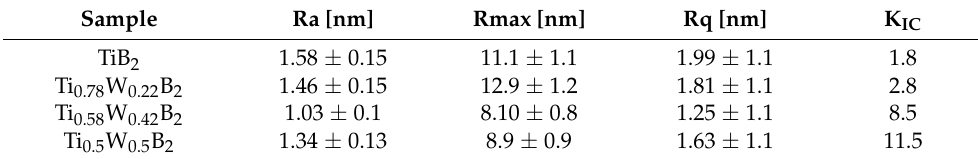
Table 2. Roughness and fracture parameters of coatings determined by